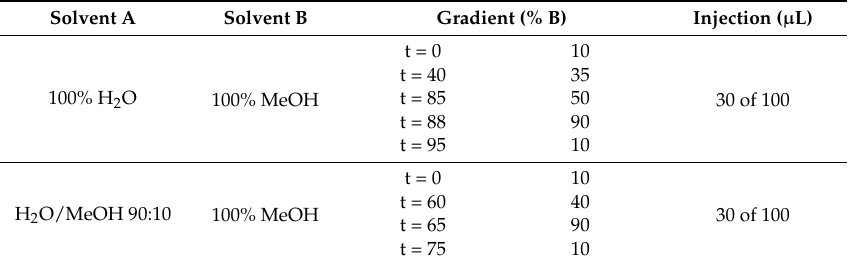
Table 3. Multi-step gradient